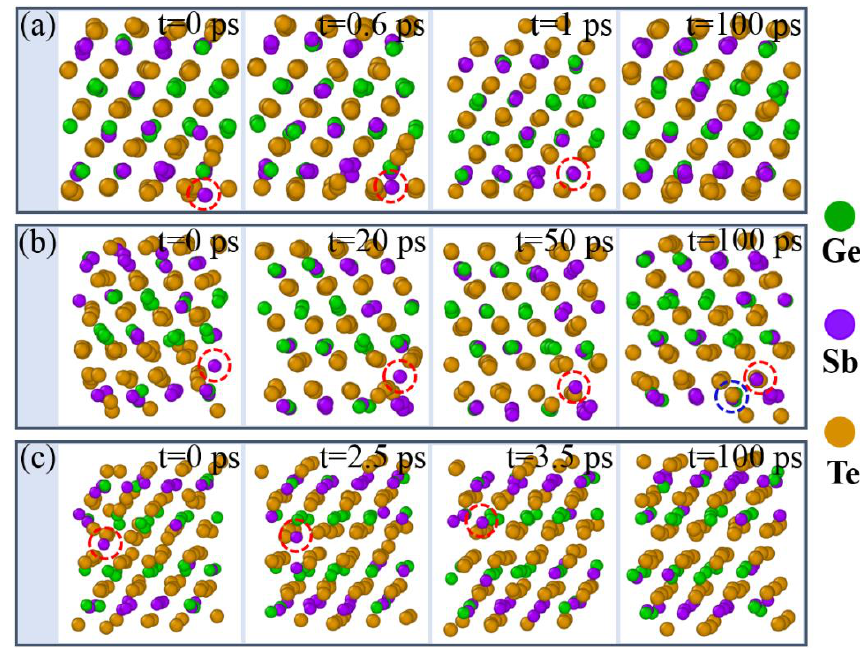
Figure 3. Key snapshots of GST-SL models at different times during the 700 K annealing, ( a – c ) show the RESET structures of the Kooi-mix, Ferro-mix, and Petrov-mix model, respectively.